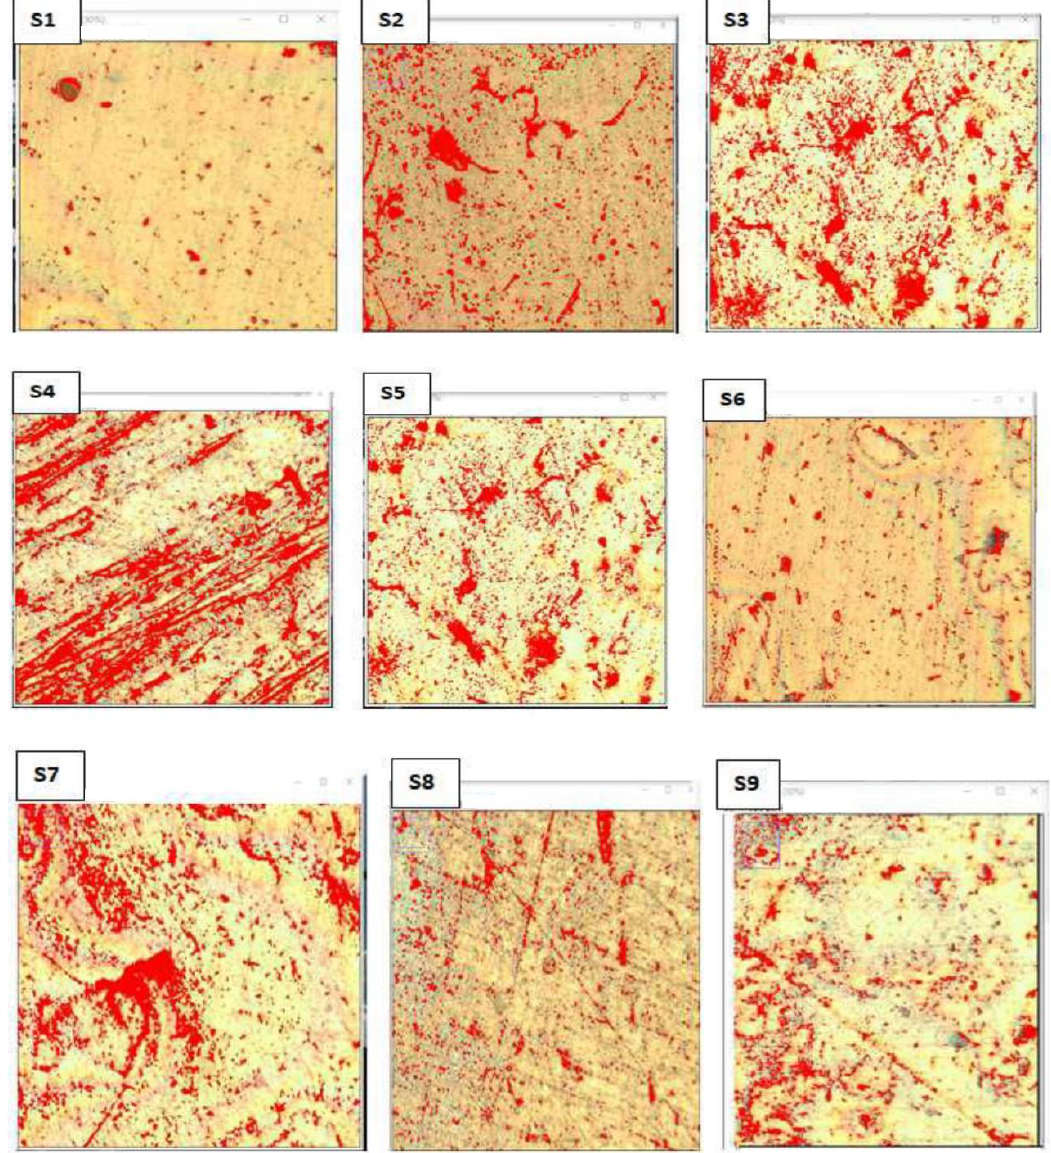
Figure 2. Optical microscopic images showing particle distribution. From the analysis, the volume fractions of grain particles were proportional to each other’s (i.e., the higher reinforcement weight of contents in the matrix, the higher the volume fraction). Sample 3, which has the higher weight percentage of SiC and MoS 2 , shows the higher volume fraction; Sample 1, which has no weight percentage of SiC and MoS 2 , shows the smaller volume fraction in the microstructural analysis as shown in Table 5.